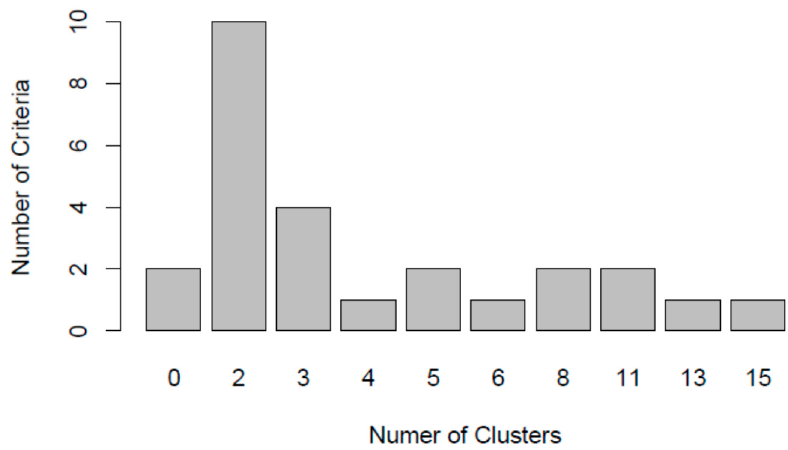
Figure 2. Ward’s Dendrogram.